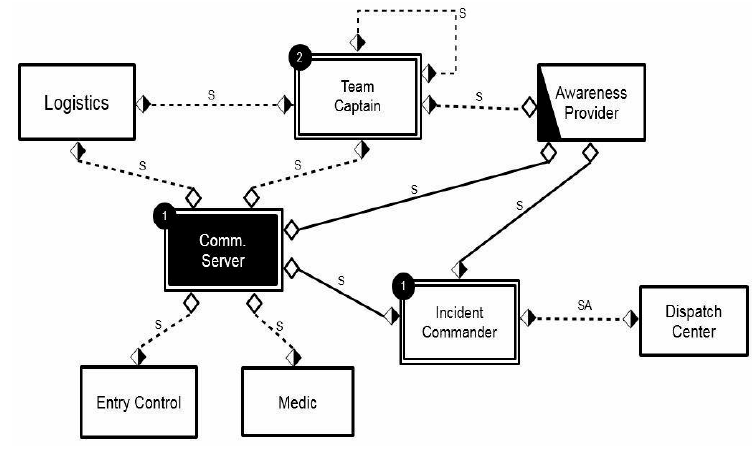
Figure 1. Example of a RI graph for an urban emergency response process specified using